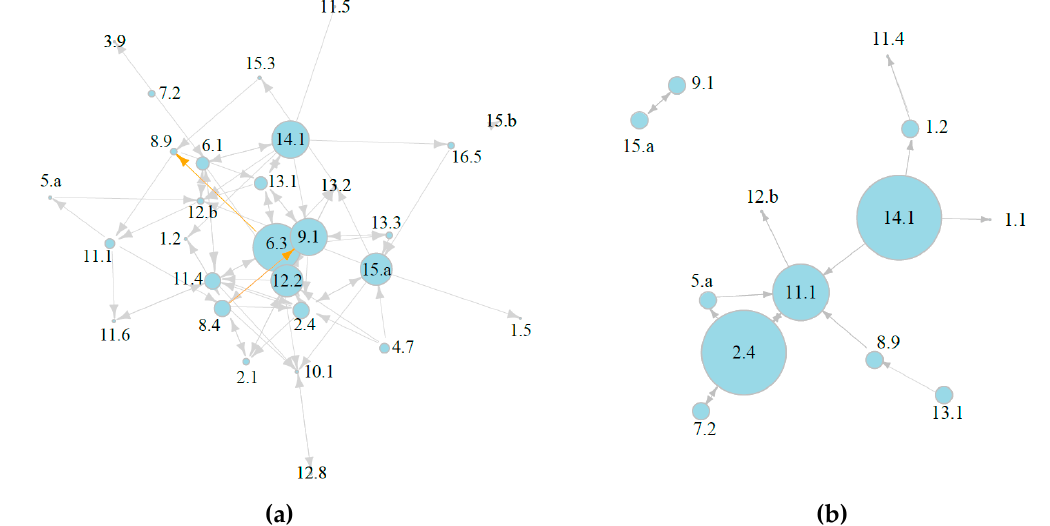
Figure 5. Bidirectional unimodal networks of: Negative ( a ) constraining ( − 1) with most frequent interactions shown in orange, and ( b ) counteracting ( − 2) interactions between the targets considered priority by wetland researchers, presented in a similar way to Figure 4. In ( b ), no interactions were mentioned by more than one researcher.